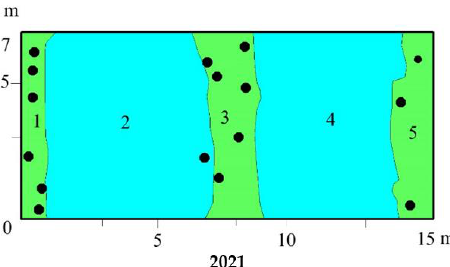
Figure 9. Changes in vegetation on permanent plot No. 7: 1 Pinus sylvestris – Vaccinium uliginosum + Calamagrostis epigejos ; 2 Comarum palustre – Sphagnum riparium ; 3 P. sylvestris – V. vitis-idaea ; 4 Calla palustris – Sphagnum riparium ; 5 P. sylvestris – Ledum palustre ; • single trees of Betula pubescens . The colours in this and other drawings highlight the areas: light green — dominated by pine and other conifers; dark green — dominated by deciduous trees; red — bare peat with possible sparse vegetation; blue — open water, with possible aquatic vegetation; blue — hygrophilous vegetation,